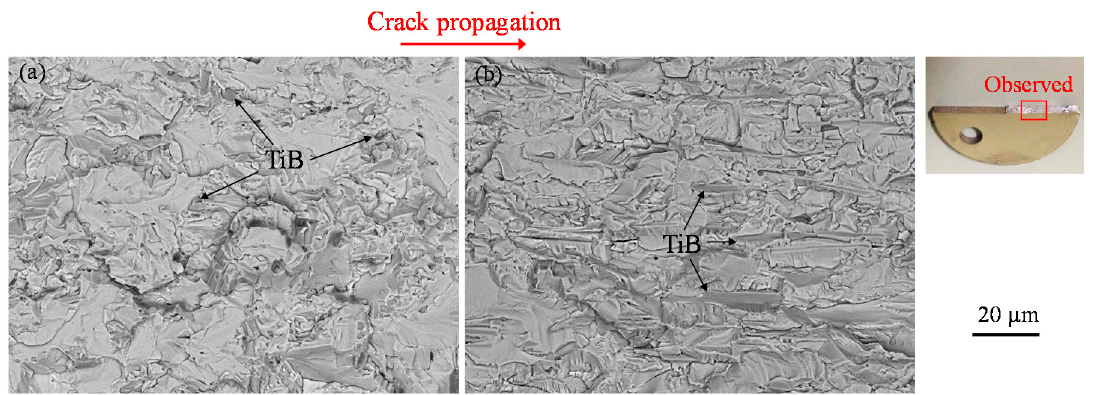
Figure 8. BSE images obtained by SEM observations for fracture surfaces for ( a ) LT and ( b ) TL series after testing at R = 0.1.